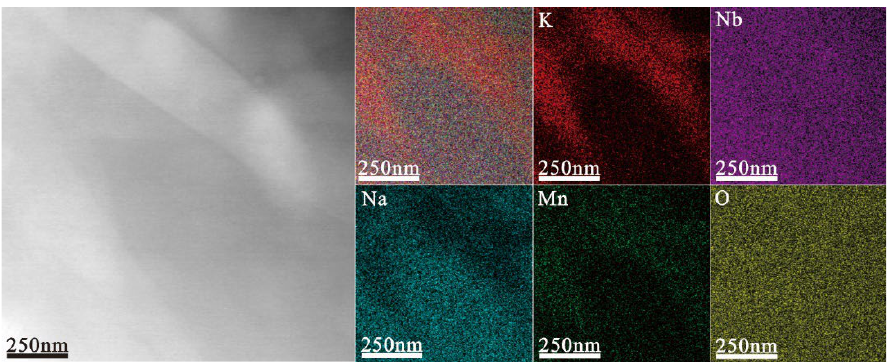
Figure 5. TEM/EDX surface scan elements of KNMN coating.